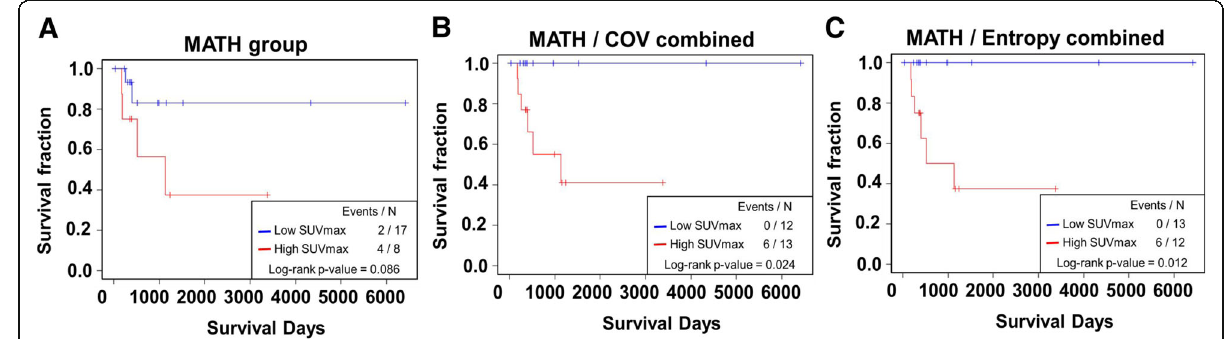
Fig. 6 Predictive value of combined MATH and FDG PET features. Kaplan-Meier curves of each group divided with adjusted cutoff value of the features. a MATH showed a trend of prediction of OS ( P = 0.086). b, c When MATH and FDG features were combined, the predictive value became more robust (B: MATH+COV, P = 0.024, C: MATH + Entropy, P = 0.012). Low group = patients in low group for both features; High group = patients in high group at least one feature. Of note, low and high groups are divided according to the optimized cut-offs obtained by cut-off finder